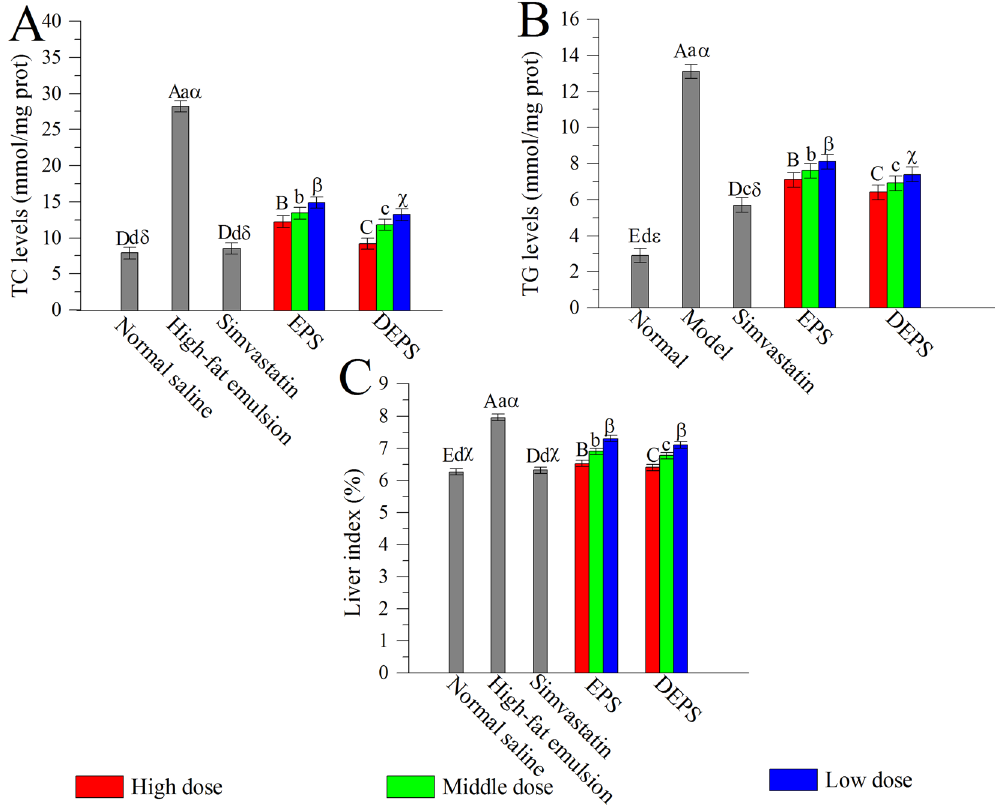
Figure 3. Effects of EPS and DEPS on liver lipid profiles in hyperlipidaemic mice: TC ( A ), TG ( B ) and liver index ( C ). Liver index (%) = liver weight/bodyweight × 100. The values are reported as means ± SD (n = 10). Bars with different letters are significantly different ( P <